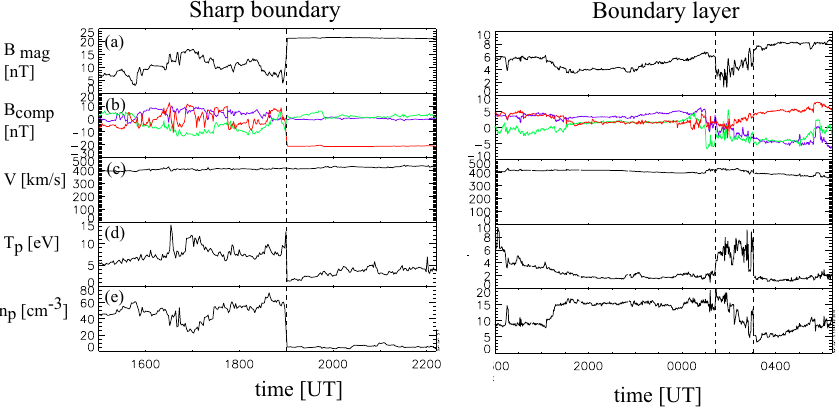
Fig. 6 Examples of sheath–ICME boundaries: a magnetic field magnitude, b components of the magnetic field in GSE coordinates ( B X : purple, B Y : green, B Z : red), solar wind c speed, d proton temperature, and e density. In the left-hand panels the dashed vertical line indicates the sharp boundary and in the right-hand panels the pair of dashed lines marks a wider boundary layer. Both cases are discussed in Wei et al. (2003a)